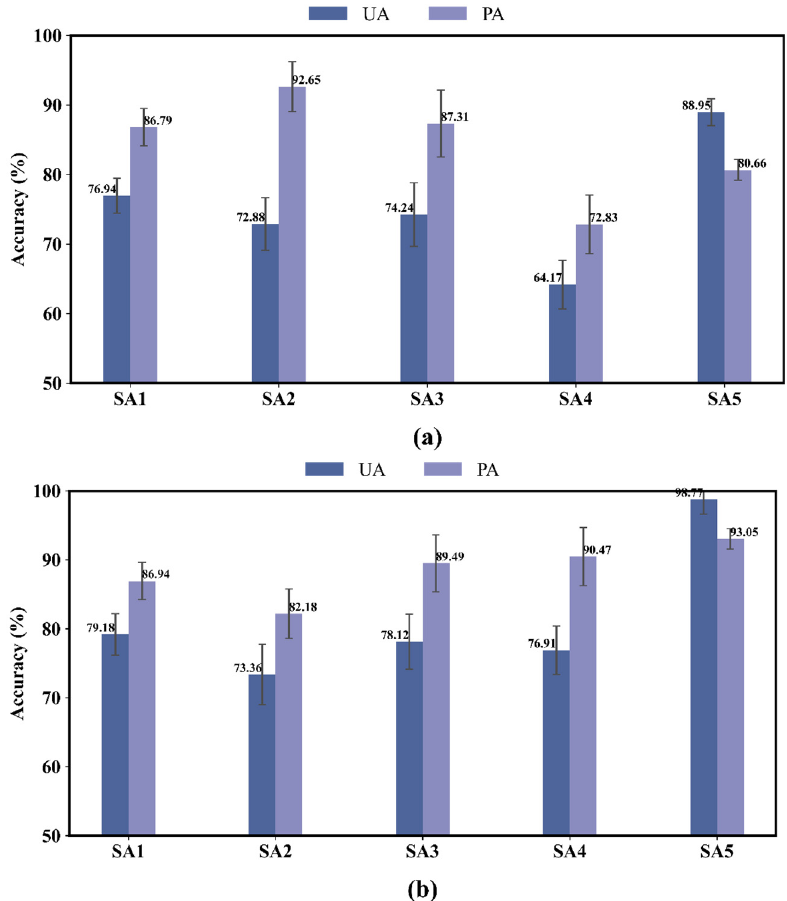
Figure 10. UA and PA for vineyards of the maps with the best OA for all study areas. ( a ) Map produced by Landsat-8 images; ( b ) maps produced by Sentinel-2 images.